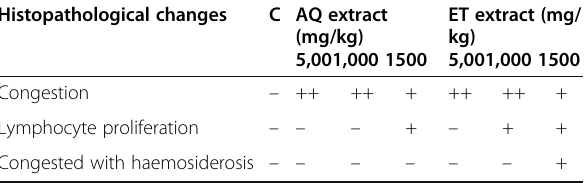
Table 6 Histopathological result of rat ’ s spleen administered aqueous and ethanolic extract of Spondias purpurea leaf Histopathological